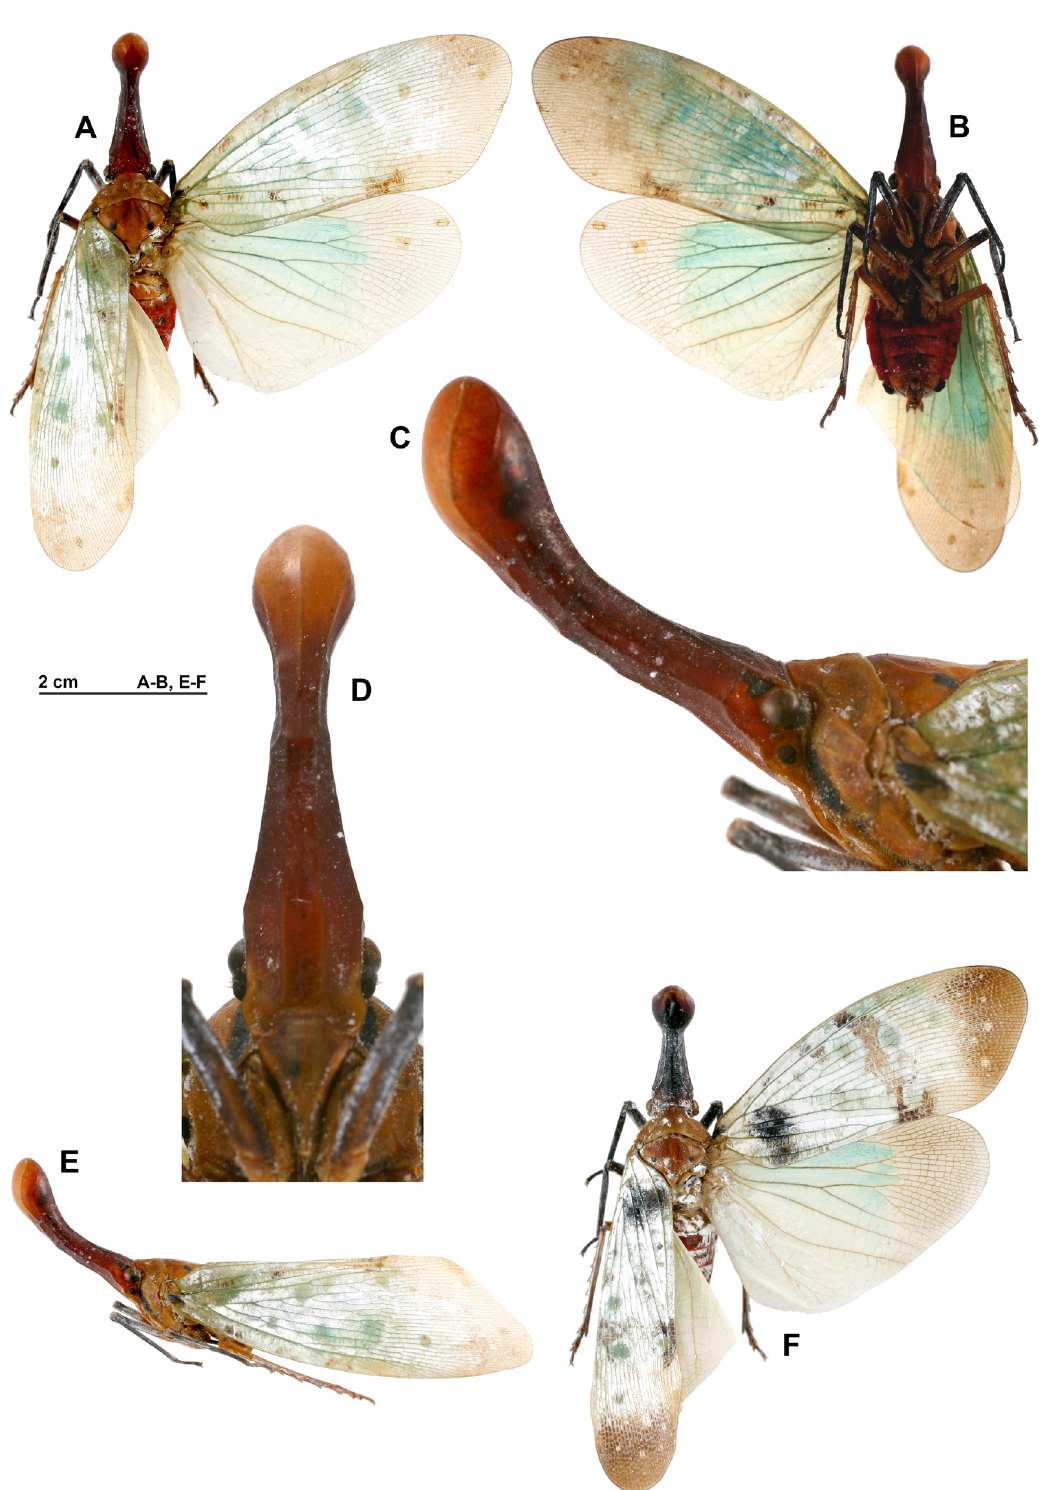
Fig. 11. Pyrops clavatus (Westwood, 1839), ♀♀, Thailand, Chiang Mai, Dec. 2007 (RBINS). A–E . Pale specimen. A . Habitus, dorsal view. B . Habitus, ventral view. C . Head and thorax, lateral view. D . Head, perpendicular view of frons. E . Habitus, lateral view. F . Intermediate specimen with cephalic process black dorsally, habitus, dorsal view. C–D = not to